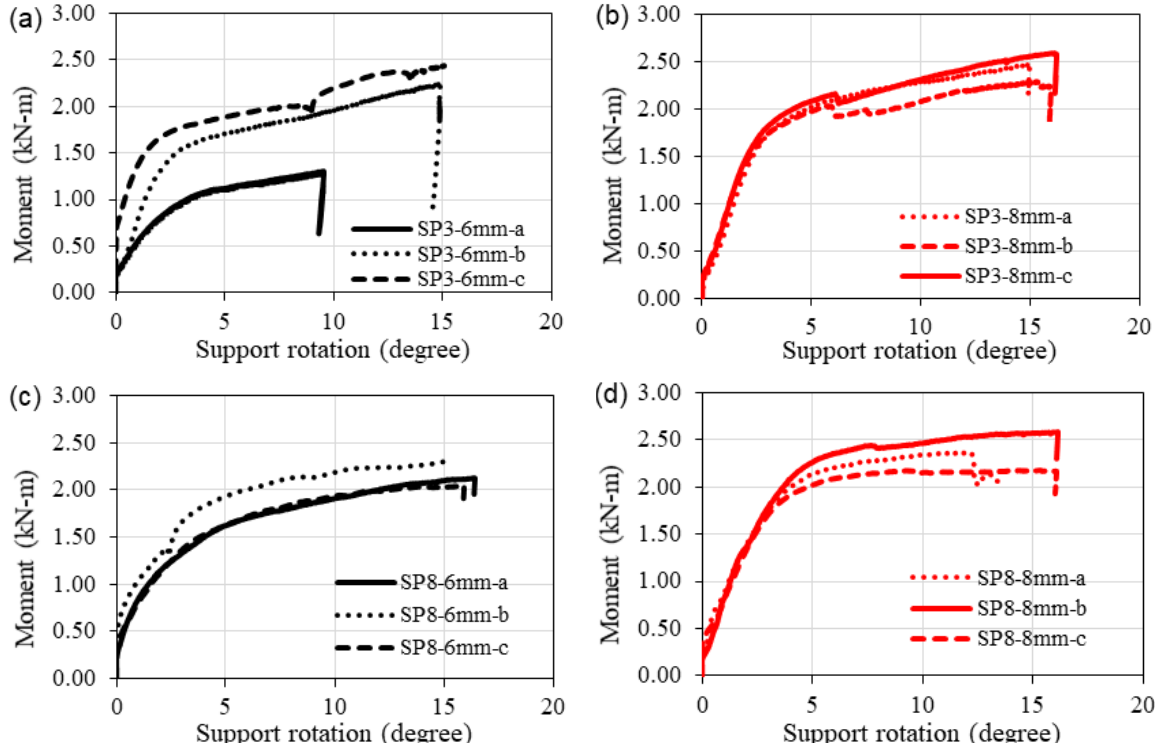
Figure 10. Moment–rotation curves of various bolted steel spline connections: ( a ) 3 mm-thick steel plate with Ø 6mm bolt, ( b ) 3 mm-thick steel plate with Ø 8 mm bolt, ( c ) 8 mm-thick steel plate with Ø 6 mm bolt and ( d ) 8 mm-thick steel plate with Ø 8 mm bolt.